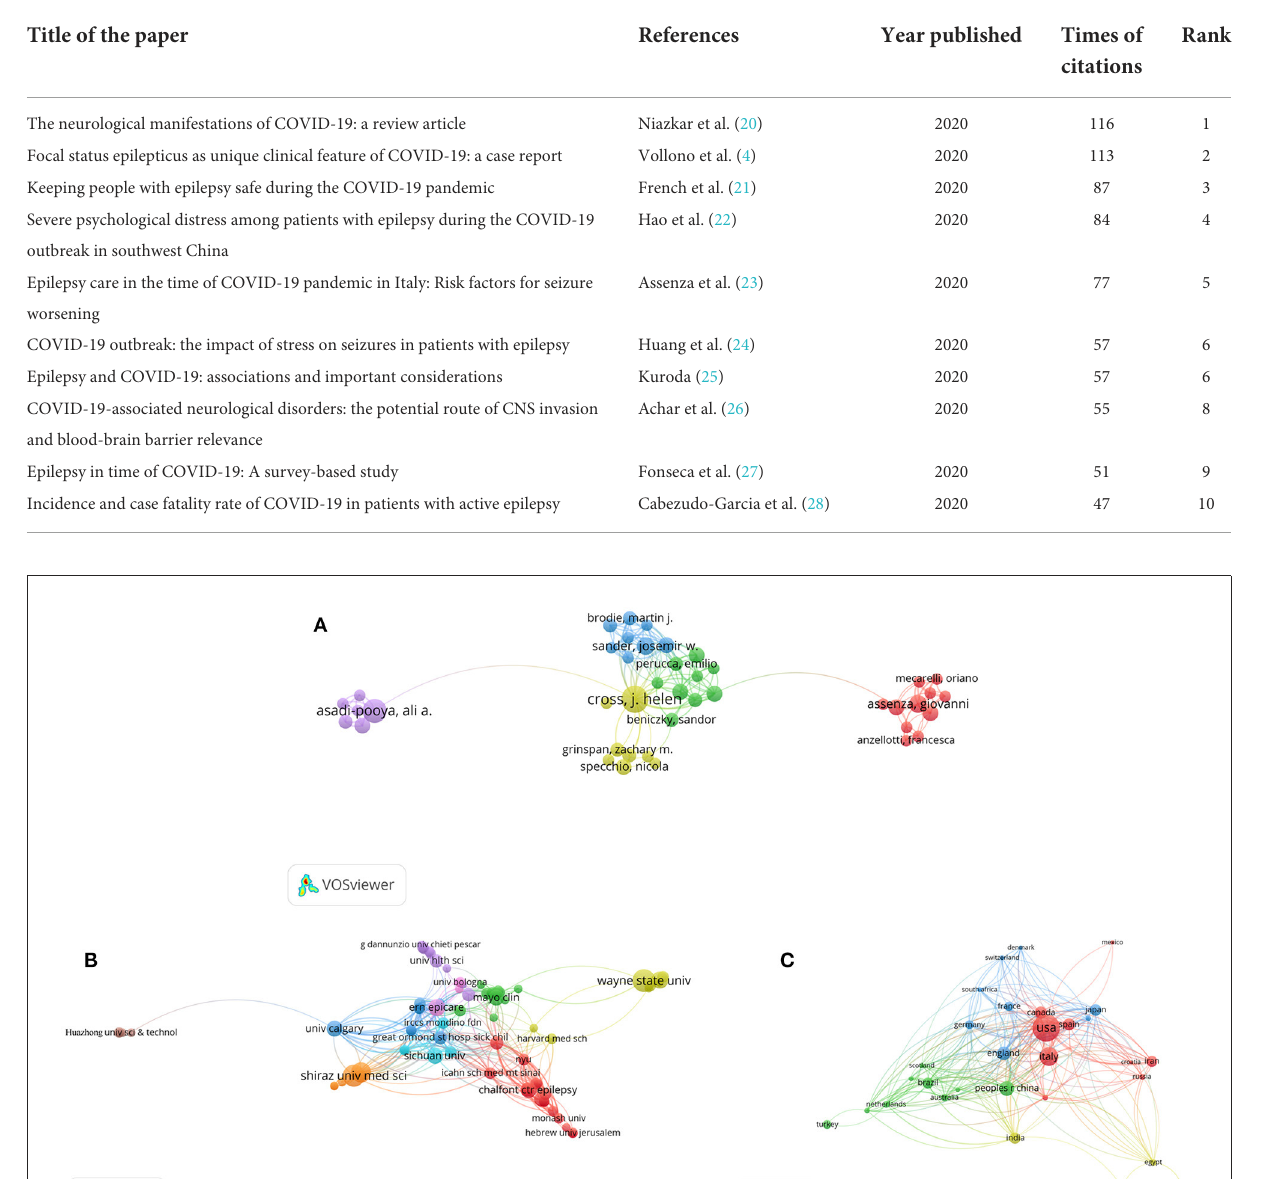
TABLE 3 Top 10 most cited papers related to COVID-19 and epilepsy.